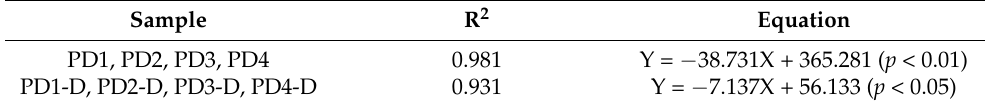
Table 4. Linear regression equations of the samples.